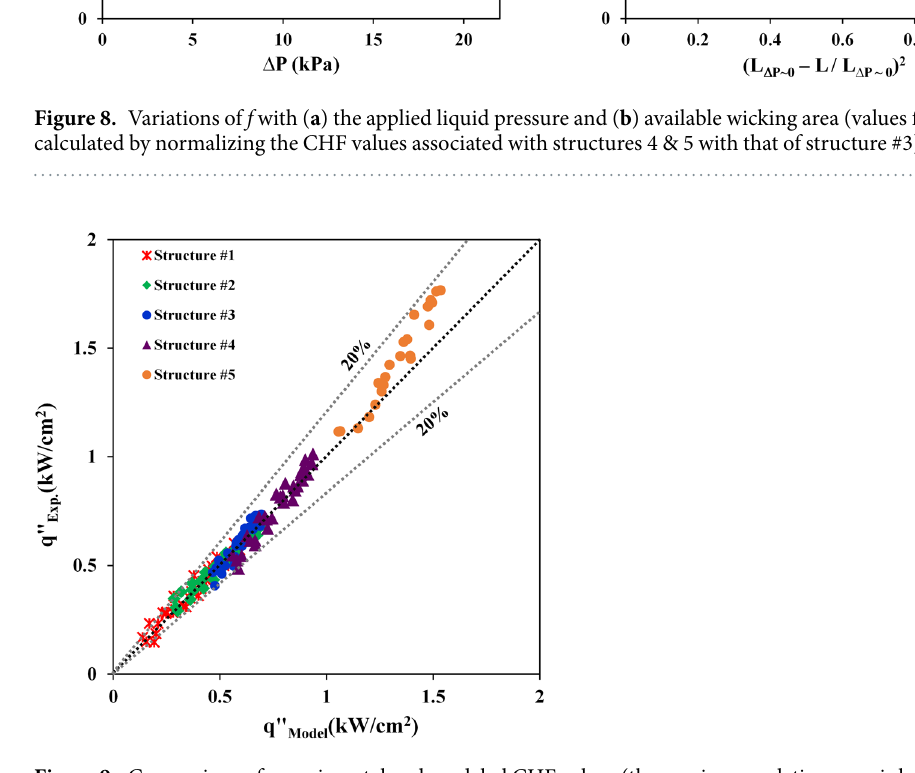
Figure 9. Comparison of experimental and modeled CHF values (the maximum relative error is less than